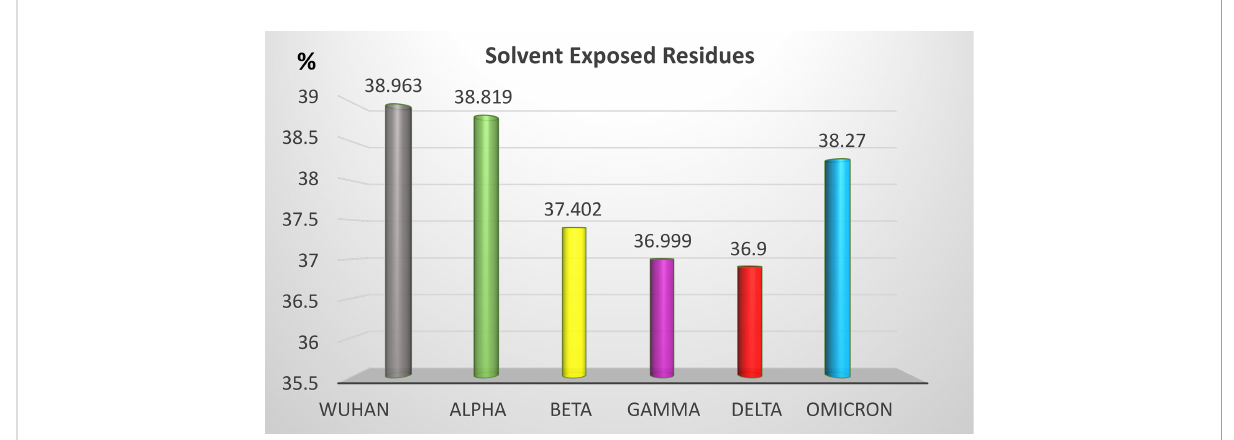
FIGURE 6 Percentage of solvent-exposed residues in the S protein of the fi ve SARS-CoV-2 VOCs. Solvent-exposed residues at the surface of the S protein are potential epitopes. Variation of the percentage of solvent-exposed residues provide a useful hint for the prediction of immunogenicity changes between variants.